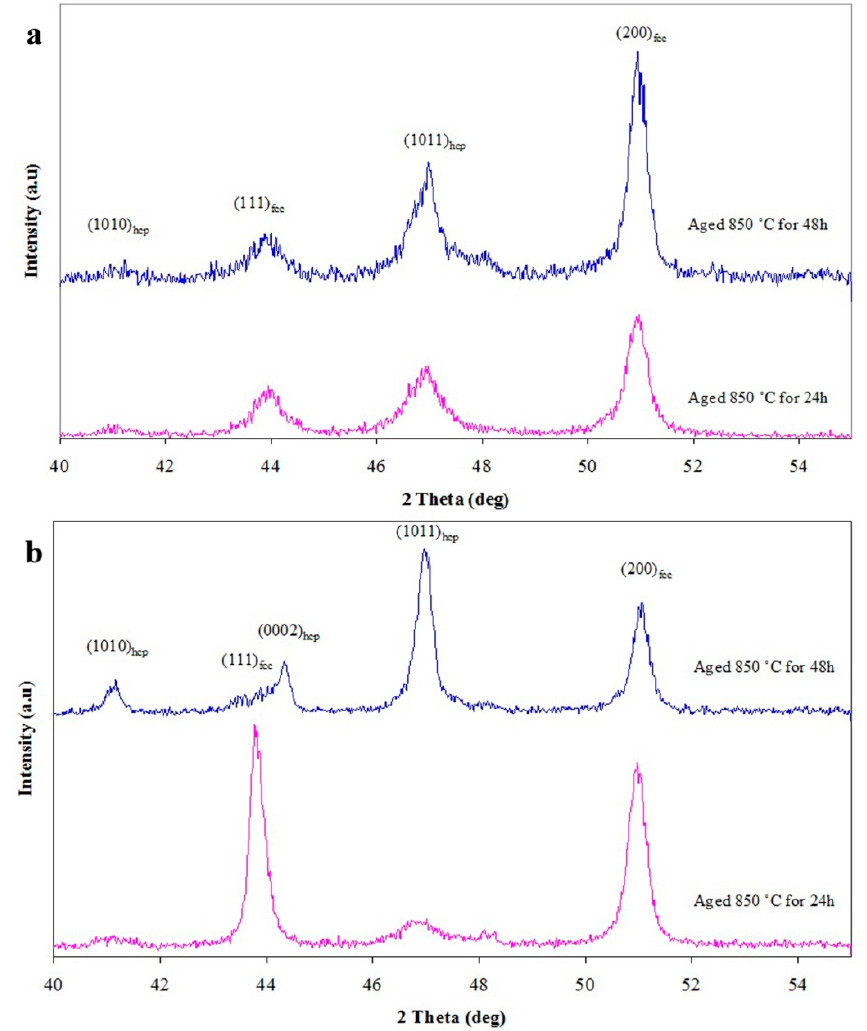
Figure 5. X-ray diffraction patterns of ( a ) the sample solution treated at 1230 ° C for 3 h and aged at Figure 5. X-ray di ff raction patterns of ( a ) the sample solution treated at 1230 ◦ C for 3 h and aged 850 ° C for 24 and 48 h, ( b ) the sample solution treated at 1200 ° C for 1 h and aged at 850 ° C for 24 and at 850 ◦ C for 24 and 48 h, ( b ) the sample solution treated at 1200 ◦ C for 1 h and aged at 850 ◦ C for 48 h. 24 and 48